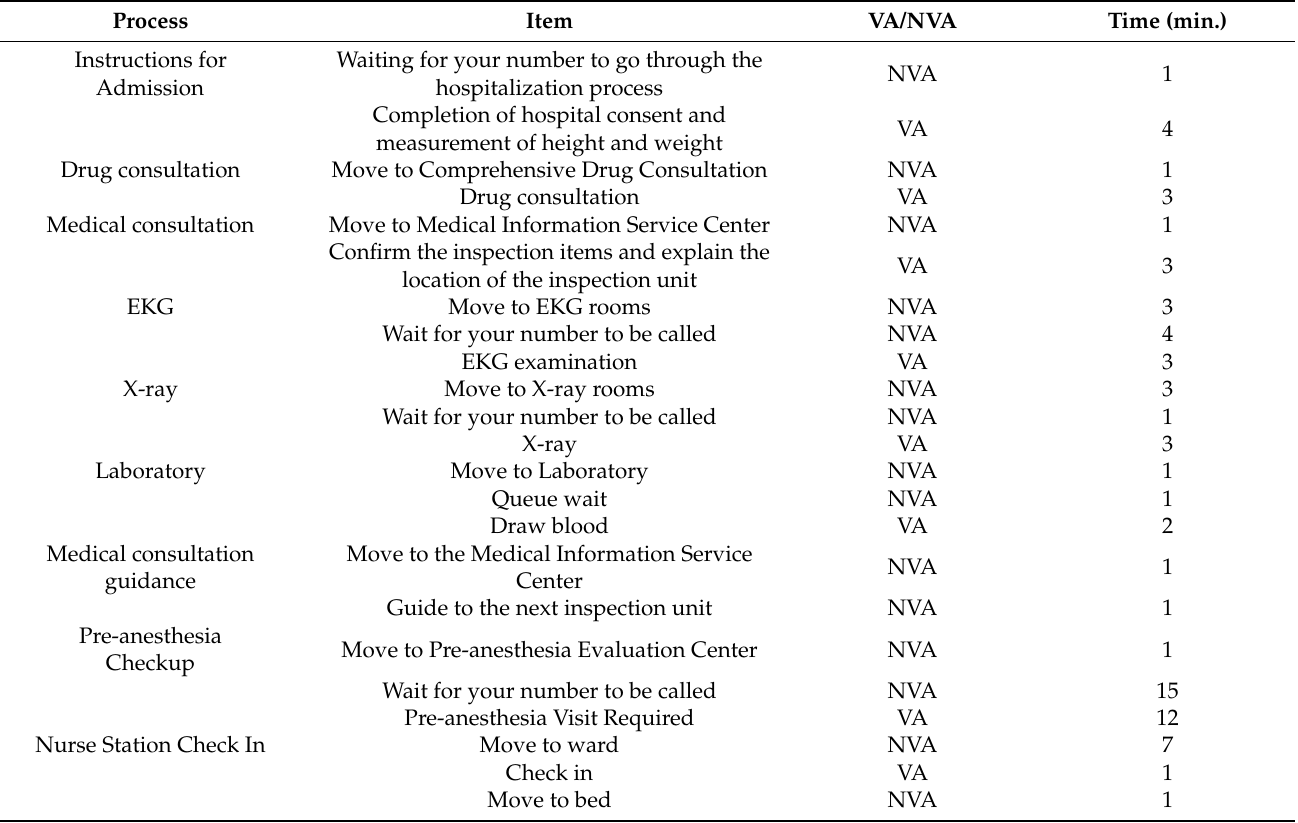
Table 6. Detailed flow chart for hospitalization procedures.